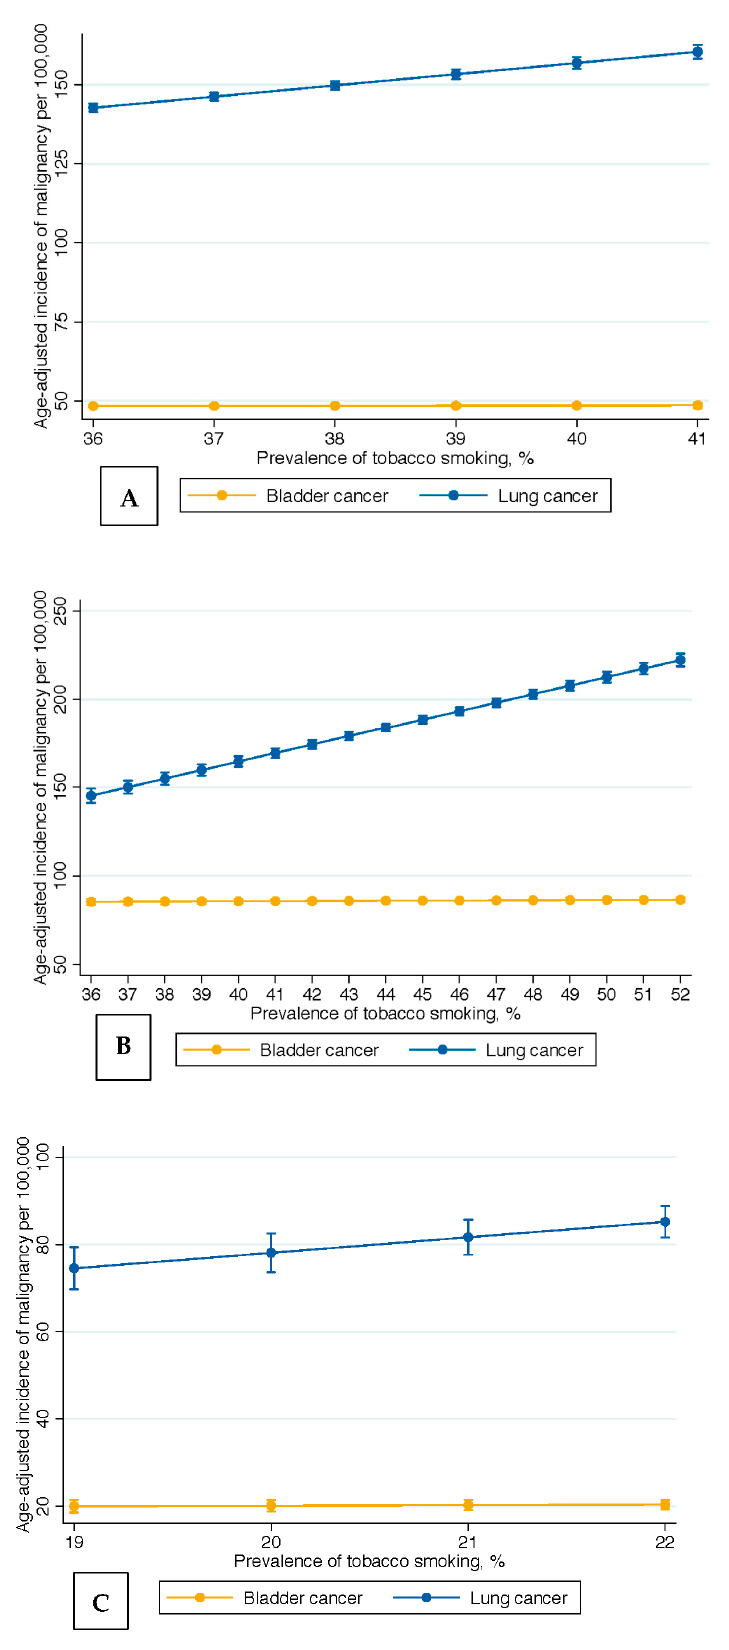
Figure 2. Impact of increasing tobacco smoking prevalence on bladder and lung cancer incidences in the ( A ) overall, ( B ) male, and ( C ) female United States populations over the past-half century.